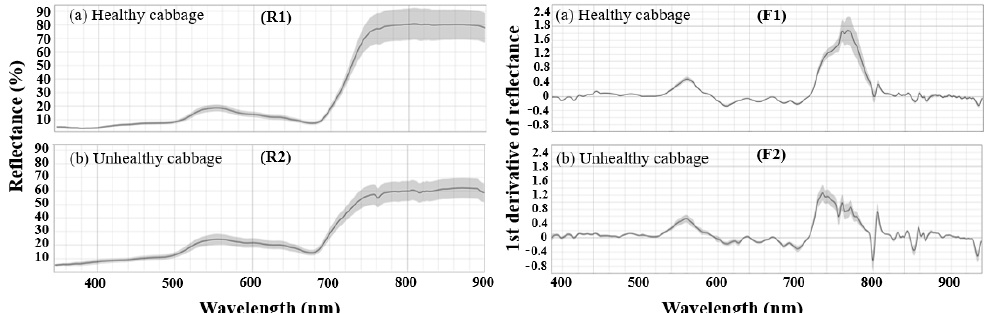
Figure 6. Differences in the spectral reflection characteristics (R1 and R2) and the first derivative of the spectral reflection curve (F1 and F2) between (a) healthy cabbage and (b) unhealthy cabbage. Figure 7a shows the first derivative of the spectral reflectance of healthy and unhealthy cabbages. As a result of the spectral analysis, there was a reliable difference in the slopes of the reflectance between the three wavelength regions. Figure 7b,c compare the differences between healthy and unhealthy cabbages in the three wavelength bands in which the change in the spectral reflection characteristics of cabbage was the greatest. First, in Figure 7b, there are differences in the range of from about 510 to 530 and 570 nm corresponding to the green wavelength. In the green band range, the reflectance slope graph of the healthy cabbage is steeper than that of the unhealthy cabbage. It can be confirmed that the growth condition of cabbage is highly correlated with PRI, as shown in Table 3.